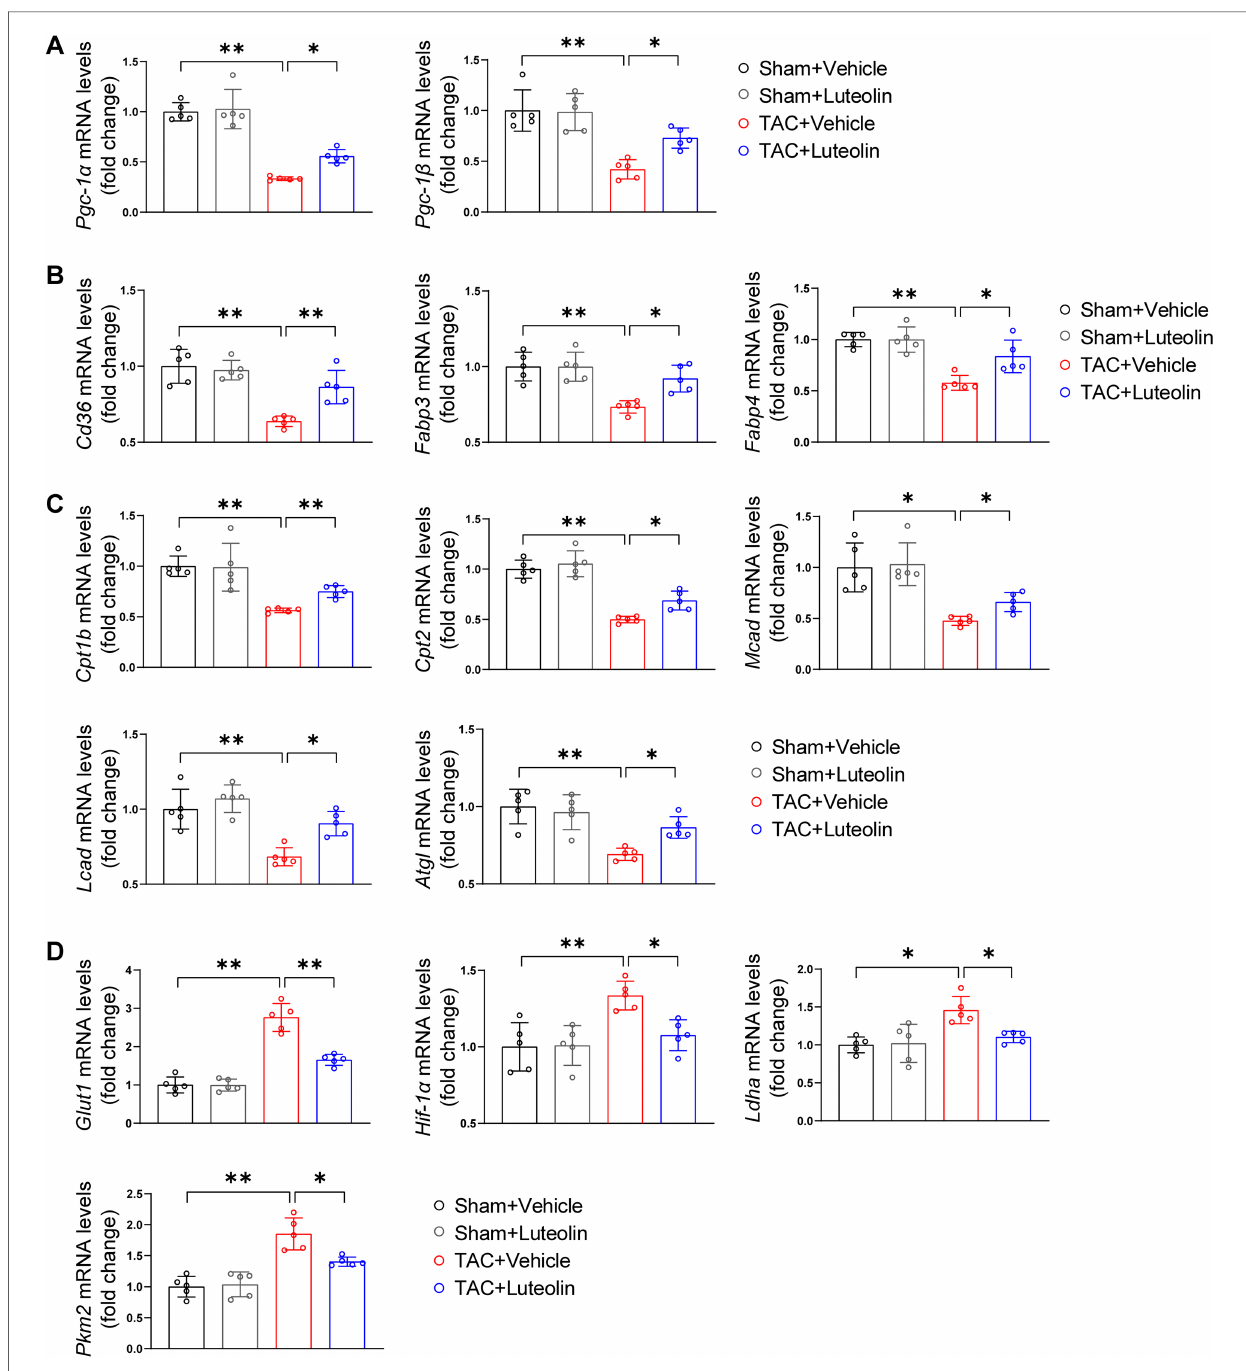
FIGURE 5 Luteolin enhances fatty acid metabolism and decreases glucose metabolism in the mouse failing hearts. ( A ) Relative mRNA levels of PPAR γ coactivator-1 α and PPAR γ coactivator-1 β in the mice hearts at 12 weeks after sham or TAC surgery ( n =5). ( B,C ) Relative mRNA levels of genes associated with fatty acid uptake ( B ) and fatty acid oxidation ( C ) in the mice hearts at 12 weeks after sham or TAC surgery ( n =5). ( D ) Relative mRNA levels of genes associated with glucose metabolism in the mice hearts at 12 weeks after sham or TAC surgery ( n =5). Values are presented as mean±SD. * P <0.05, ** P <0.01. Pgc-1 α / β , peroxisome proliferative activated receptor-gamma coactivator-1 α / β ; Fabp3/4 , fatty acid binding protein 3/4; Cpt1b/2 , carnitine palmitoyltransferase 1b/ 2; Mcad , medium-chain acyl-CoA dehydrogenase; Lcad , long-chain acyl-CoA dehydrogenase; Atgl , adipose triglyceride lipase; Glut1 , glucose transporter 1; Hif-1 α , hypoxia-inducible factor 1 α ; PPAR γ , peroxisome proliferator activated receptor γ ; Ldha , lactate dehydrogenase A; Pkm2 , pyruvate kinase